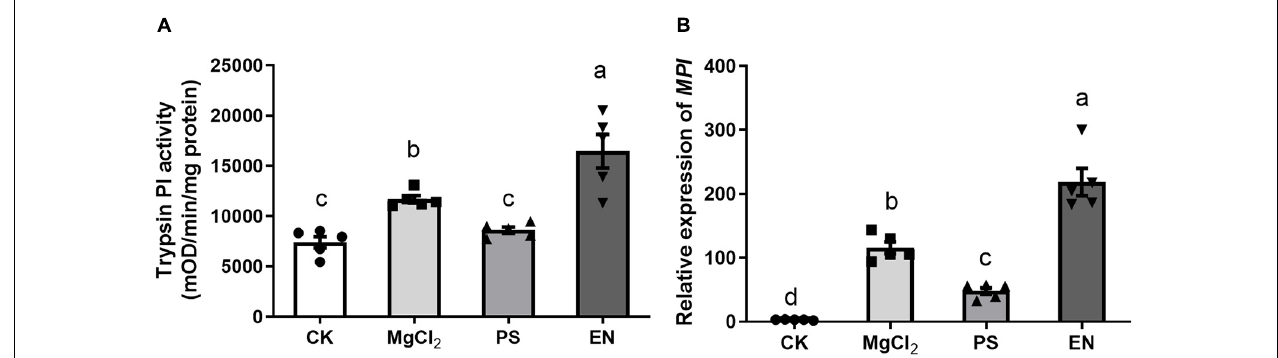
FIGURE 5 | Impacts of caterpillars inoculated with Pseudomonas (PS) and Enterococcus (EN) on herbivore-induced defense response in maize plants. (A) Trypsin proteinase inhibitor (Trypsin PI) activity ( F 3 , 16 = 19.12, p < 0.001, Fisher’s test) and (B) MPI gene expression ( F 3 , 16 = 62.14, p < 0.001, Fisher’s test) in maize plants treated by fall armyworm larvae inoculated with PS or EN. CK, plants without any damage; MgCl 2 , plants damaged by caterpillars with only MgCl 2 buffer. Values are untransformed mean ± SEM ( n = 5). Different letters indicate significant differences between